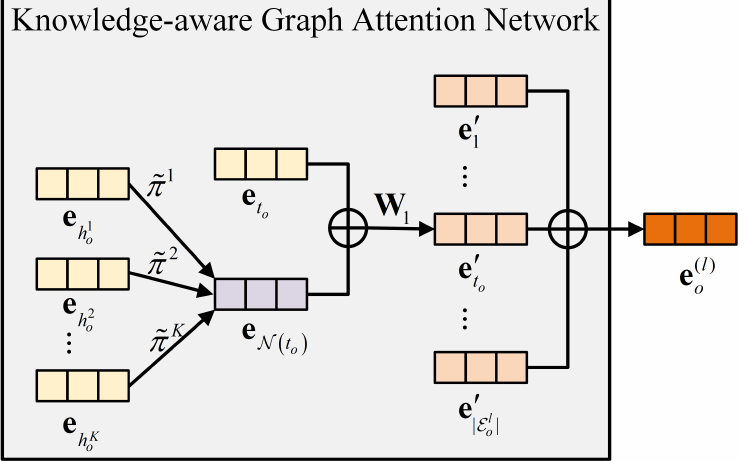
Figure 2. Knowledge-aware graph attention